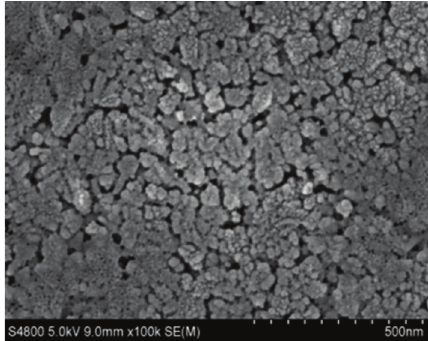
Figure 2: SEM photograph of Fe-doped TiO 2 thin film.